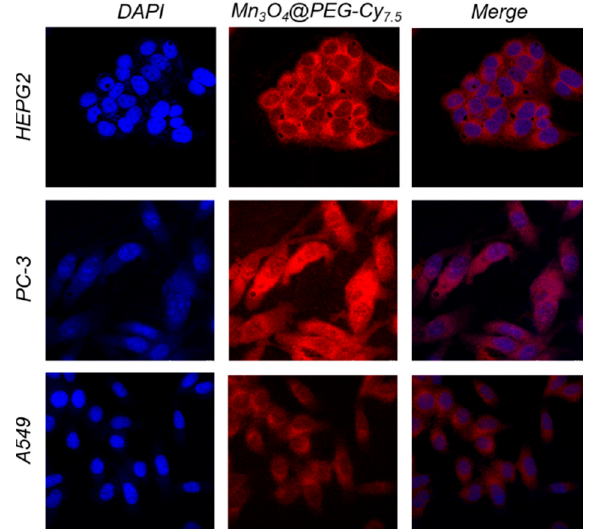
Figure 3. (First column) Cellular uptake of Mn 3 O 4 @PEG-Cy 7.5 NPs in tumor cells. Mn 3 O 4 @PEG-Cy 7.5 NPs were incubated with tumor cells for 2 h and free Mn 3 O 4 @PEG-Cy 7.5 NPs in the medium were removed by washing. The nucleus and cytoskeleton of cells were stained and subsequently imaged by a confocal microscope. (Second column) Nuclear staining of cells with DAPI and imaging of Mn 3 O 4 @PEG-Cy 7.5 NPs. (Third column) The merged imaging of the nucleus and Mn 3 O 4 @PEG-Cy7.5 NPs. 2.2. In Vitro Biocompatibility Studies of Mn 3 O 4 @PEG-Cy 7.5 NPs